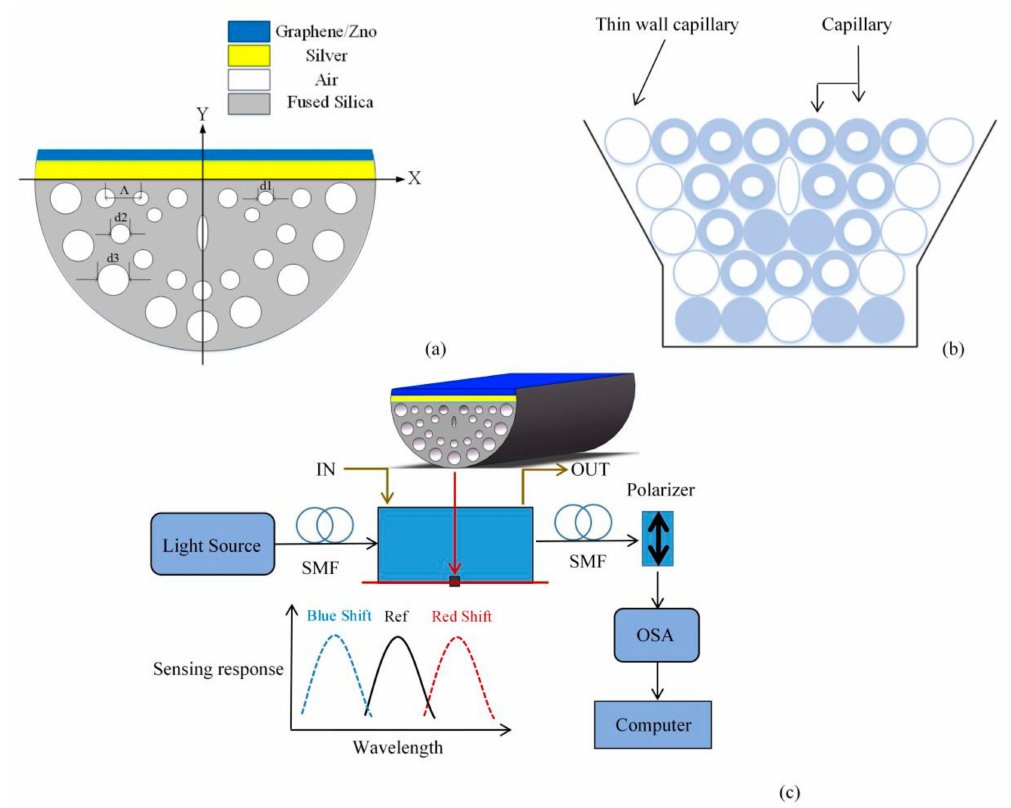
Figure 1. ( a ) The cross-section of the sensor; ( b ) stacked rough machining cross-section; ( c ) experimental setup of SPR sensor for detecting the refractive index of liquid